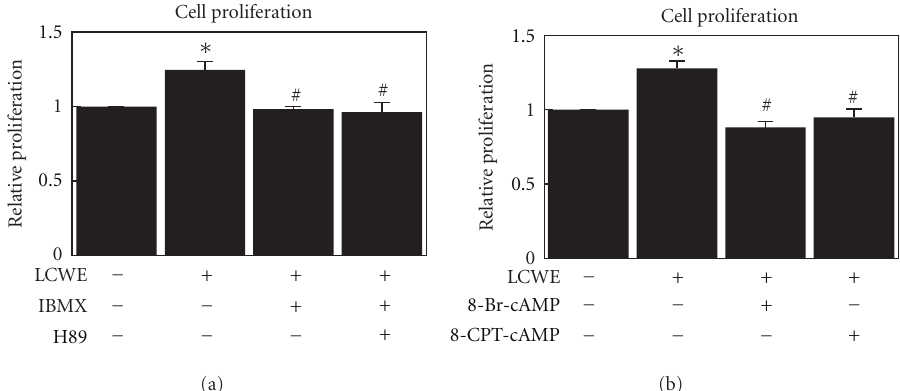
Figure 6: Change in cell proliferation after treatment with LCWE (10 μ g/mL), a combination of IBMX (1 μ M) and LCWE (10 μ g/mL), or a combination of IBMX (1 μ M), LCWE (10 μ g/mL), and H89 (5 μ M) (a) in NIH3T3 mouse fibroblast cells. Change in cell proliferation after treatment with LCWE (10 μ g/mL), a combination of 8-Br-cAMP (1mM) and LCWE (10 μ g/mL), or a combination of 8-CPT-cAMP (5 μ M) and LCWE (10 μ g/mL) (b) in NIH3T3 mouse fibroblast cells. Each column represents the mean ± SEM. ∗ P < 0 . 05 versus untreated controls. # P < 0 . 05 versus LCWE treatment